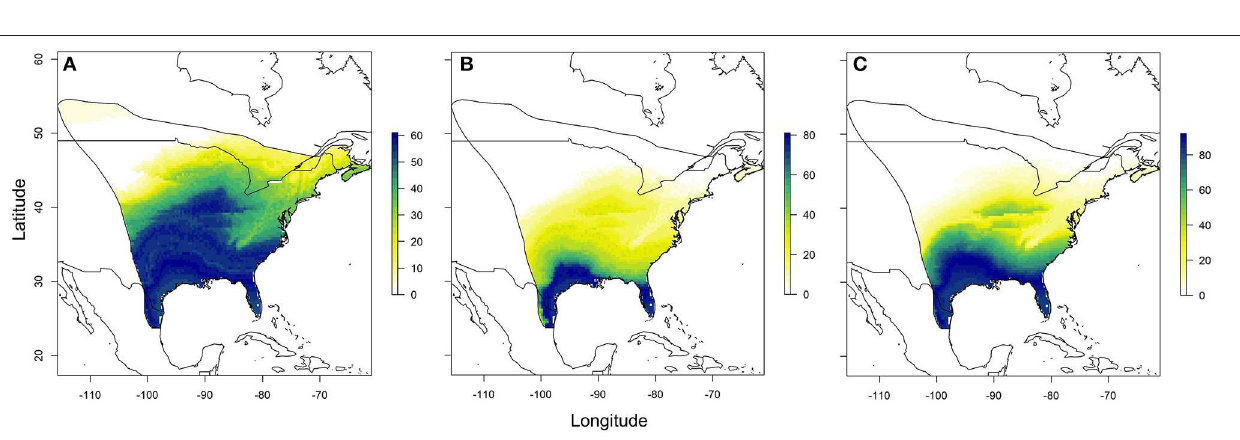
FIGURE 5 | Depiction of origins of a subsample of roadkilled monarchs during fall migration near Monterrey, Mexico, using (A) only δ 2 H w values, (B) only δ 18 O w values, and (C) both δ 2 H w and δ 18 O w values in a multivariate normal likelihood approach. Legend is the number of individuals assigned to a pixel based on the odds ratio criterion